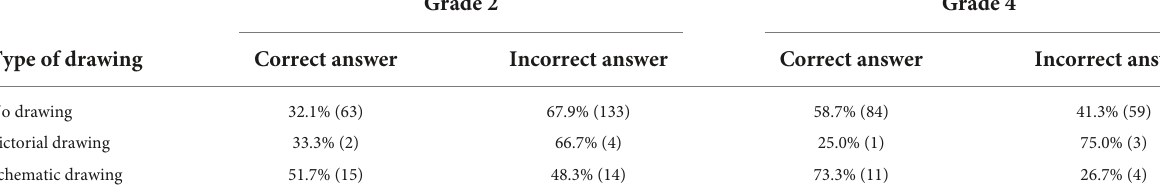
TABLE 4 Percentage and (number) of correct and incorrect answers by grade and type of drawing. Grade